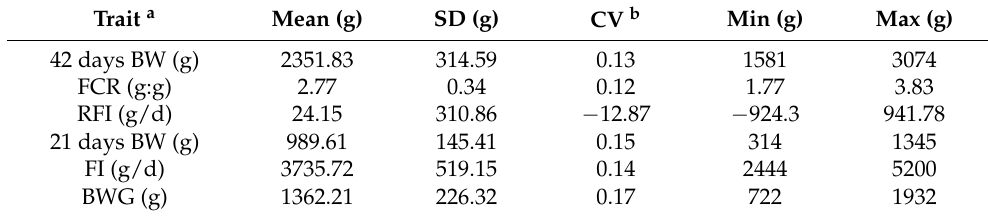
Table 1. Descriptive statistics of FE and related traits. Trait a Mean (g) SD